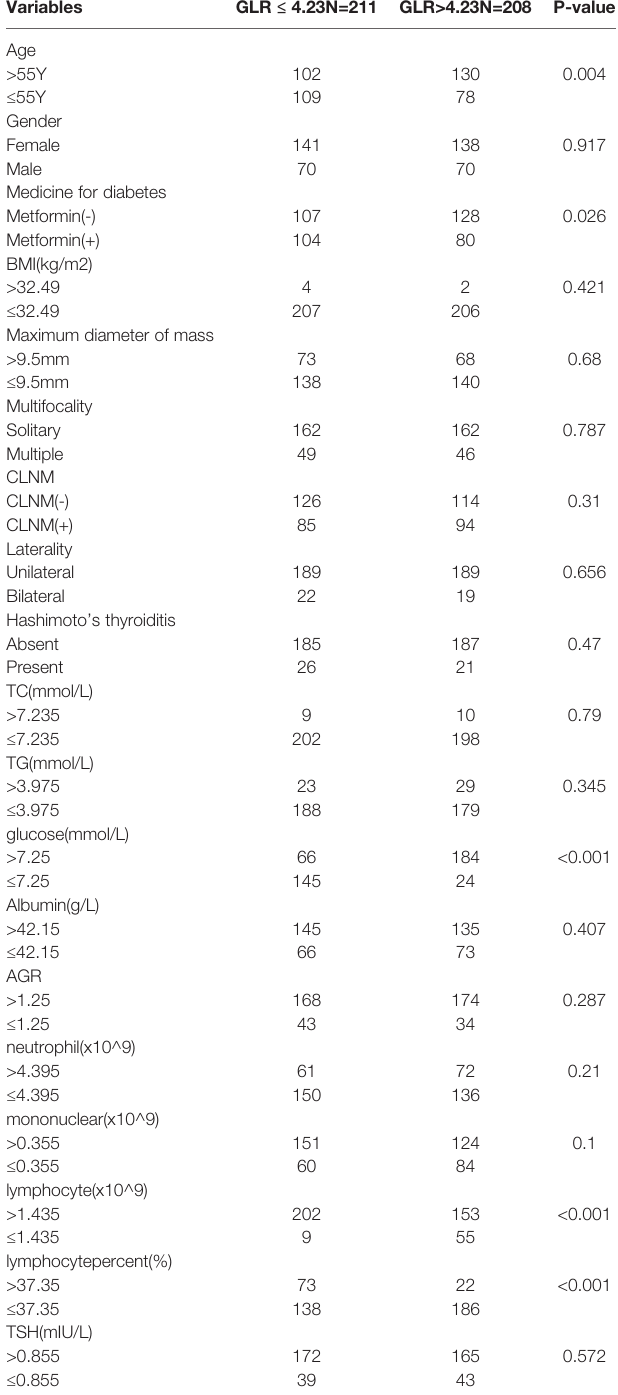
TABLE 2 | Correlations between GLR and the clinical characteristics of patients in all datasets.